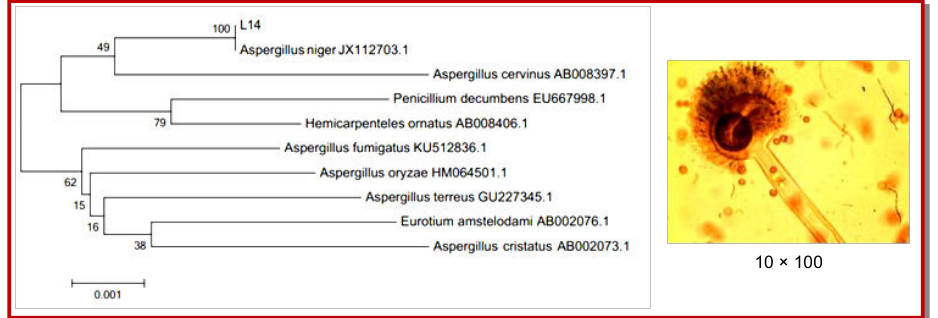
Figure 3: Molecular phylogeny and morphology of fungal strain L14